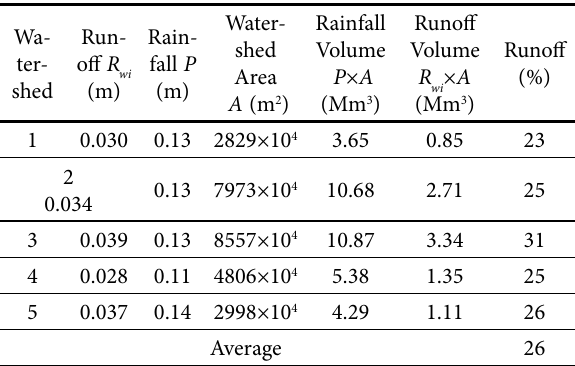
Table 6. Monthly runoff of particular watershed area of